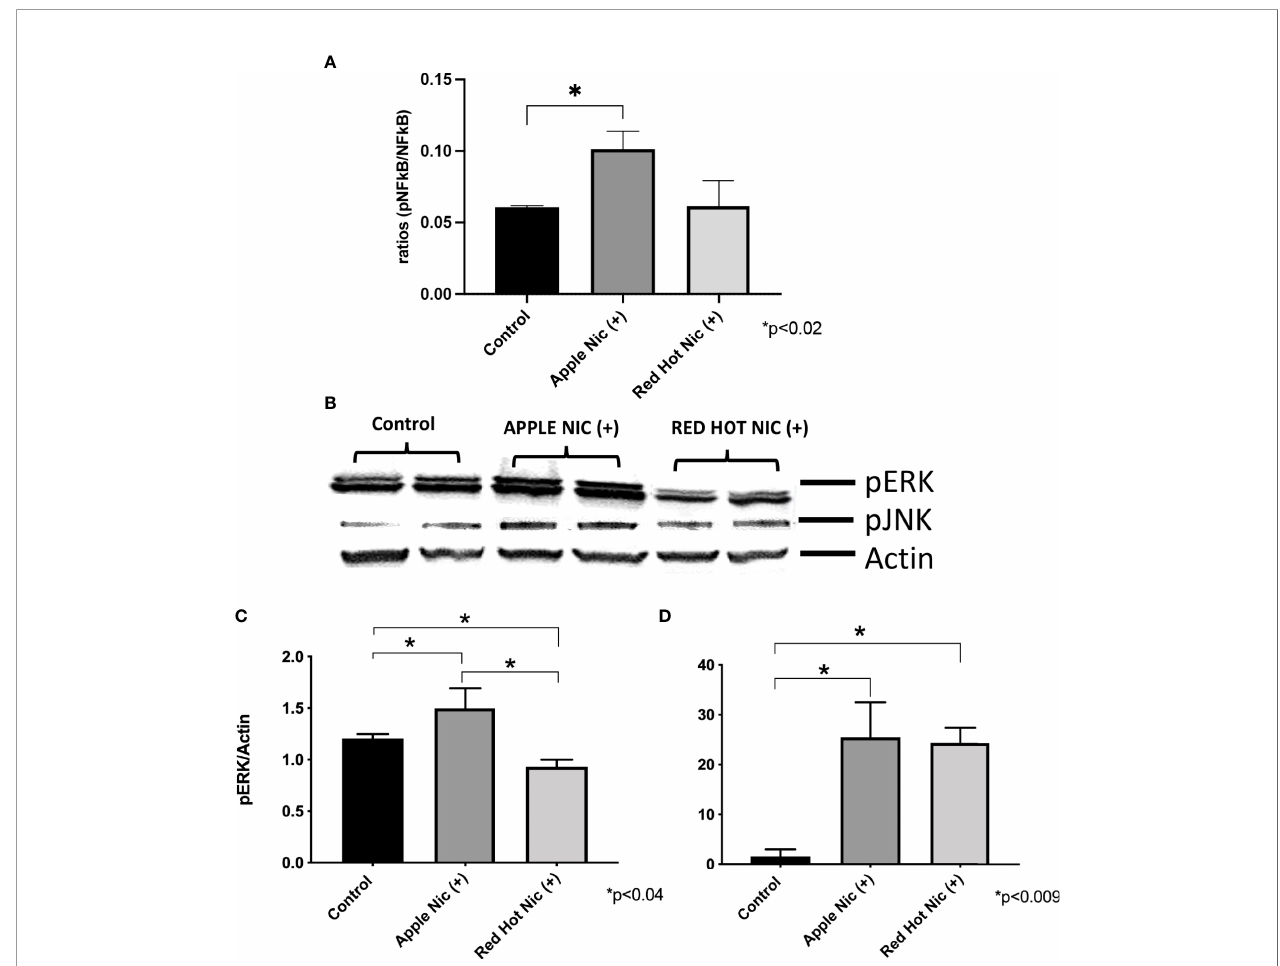
FIGURE 1 | Expression of NF- k B, pERK, and pJNK in Ca9-22 cells exposed to EVE. ELISA was performed to determine NF- k B released into the cell medium. ERK and JNK were determine by western blot. Released of NF- k B in the media was increased only with Apple EVE and nicotine EVE in treated Ca9-22 cells as compared to media only treated controls (A) . A representative western blot results for ERK and JNK us shown in (B) ERK protein was activated in cells treated with Apple EVE and Nicotine and signi fi cantly decreased in cells exposed to Red Hot EVE with nicotine (C) . JNK protein was activated by both fl avors in Ca9-22 cells when nicotine was present (D) . Data are shown with * p ≤